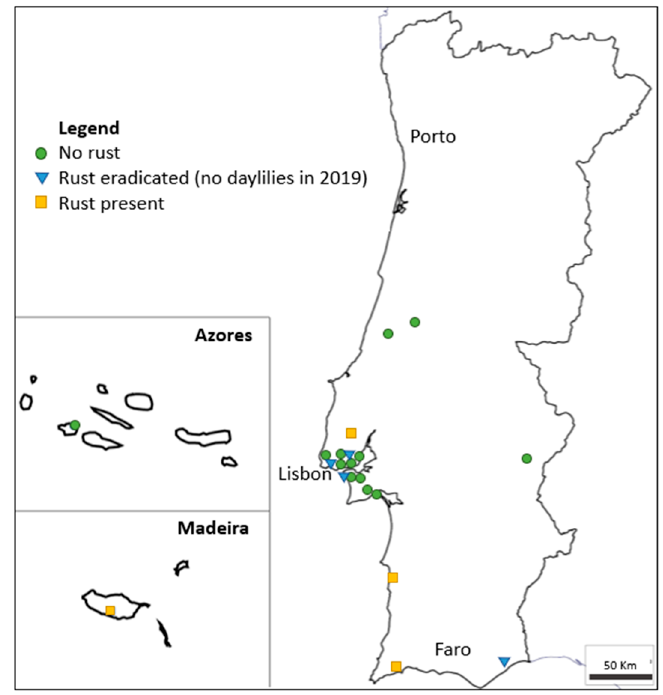
Figure 2. Occurrence of daylily rust (caused by Puccinia hemerocallidis ) in Portugal according to surveys conducted in 2019, including previous positive detections from which daylily plants (and the disease) were removed (adapted from d-maps.com).